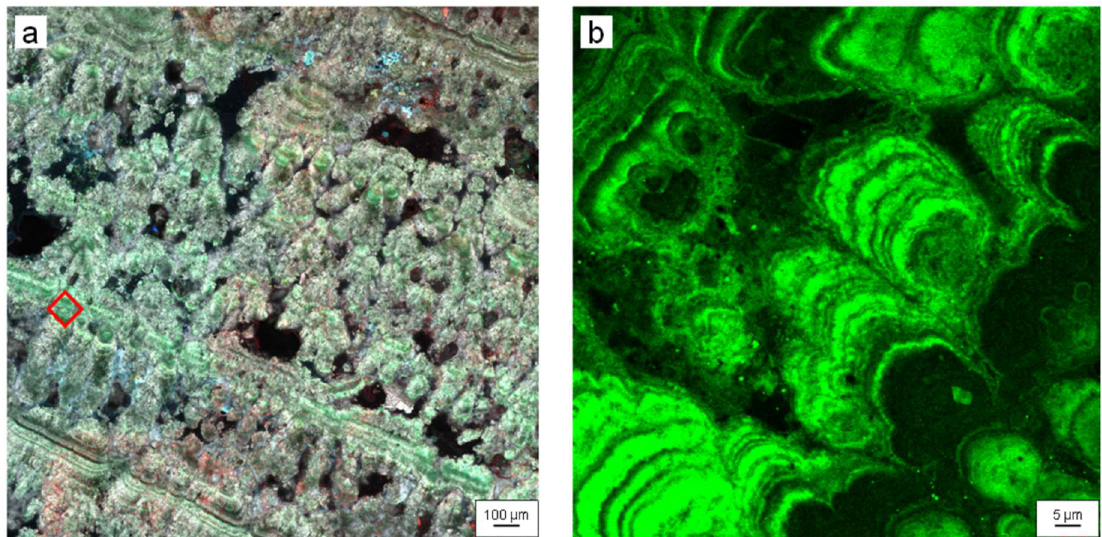
Figure 9. Visualization of confocal laser microscopy: ( a ) differences in the fluorescence of individual layers of carbonate crusts; and ( b ) alternating dark non-fluorescent and light fluorescent calcite generations within individual aggregates.